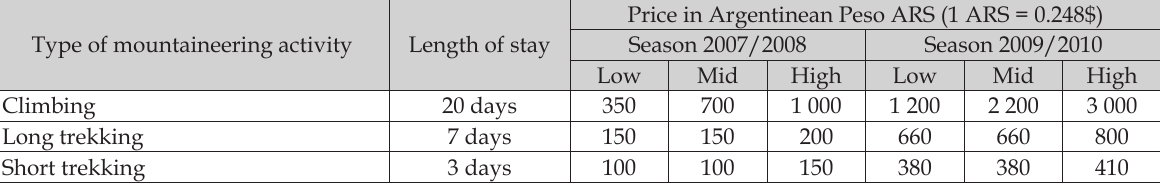
Table 3. The price of mountaineering permit in the Aconcagua massif area. Type of mountaineering activity